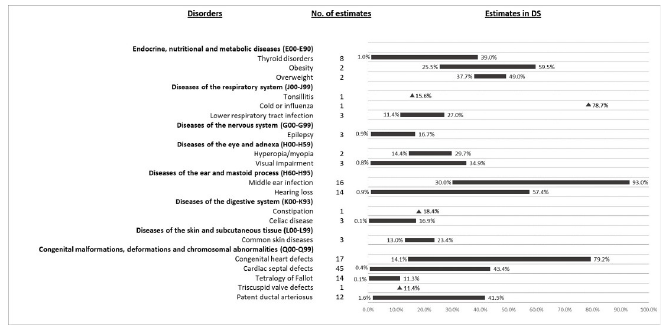
Fig 4. Prevalence range (%) of 15 most common physical health conditions in people with Down